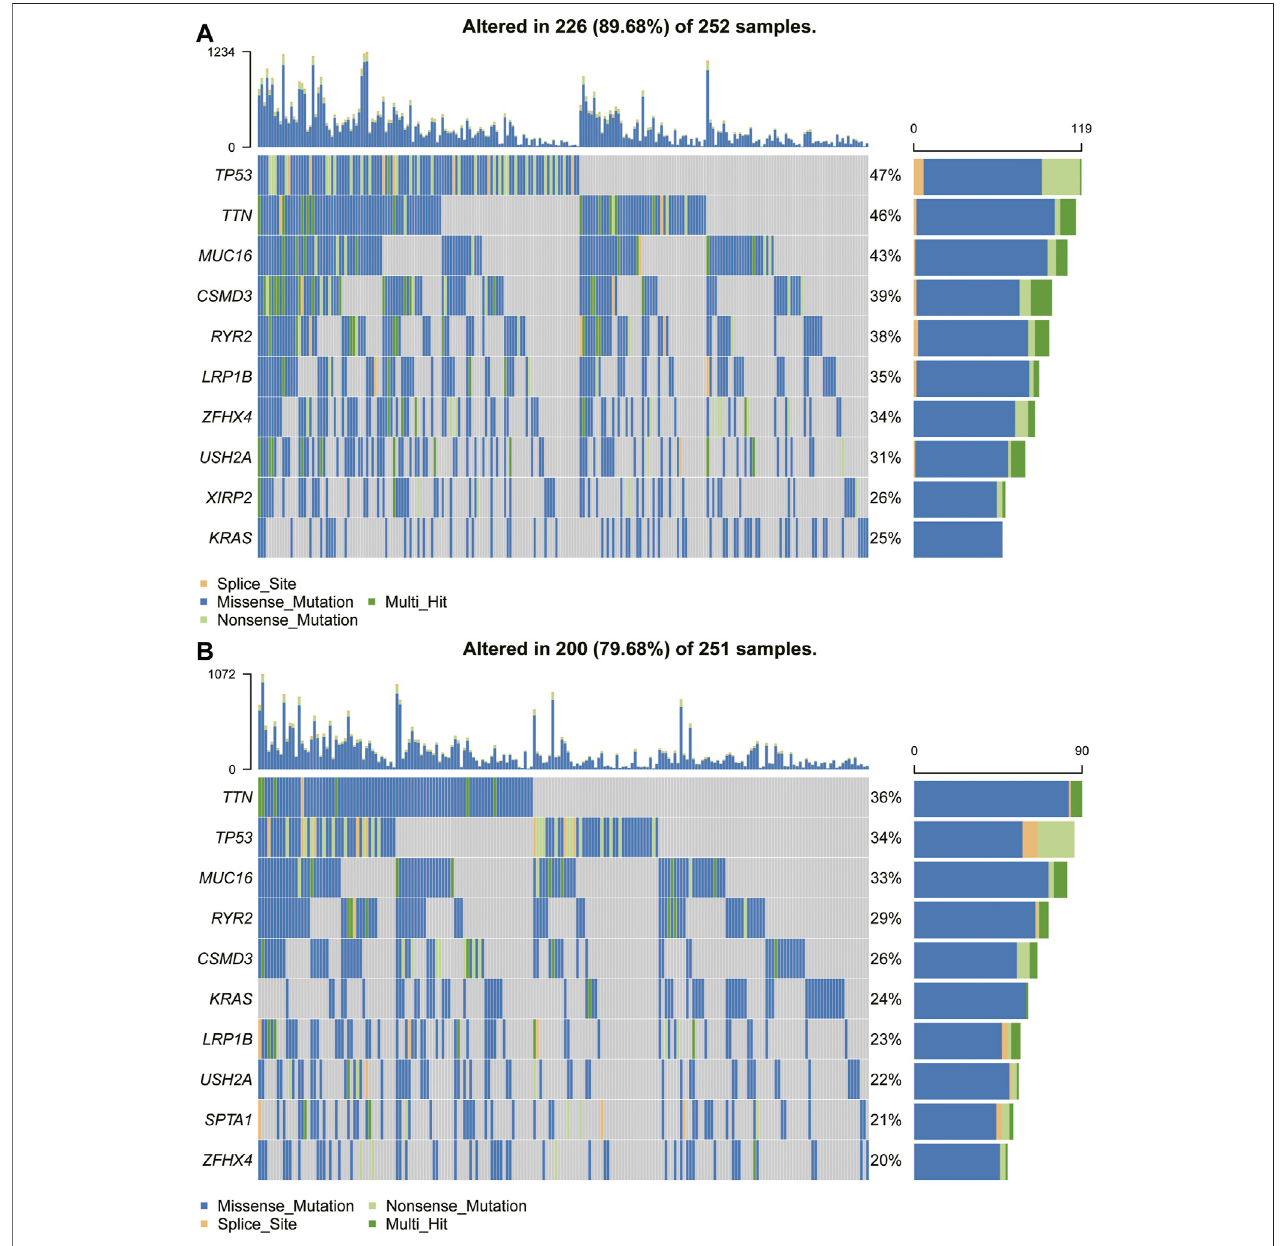
FIGURE 9 | Gene mutant frequency in high- and low-TPD52L2 groups. (A) Gene mutant frequency (top 10) in the high TPD52L2 expression group. (B) Gene mutant frequency (top 10) in the low TPD52L2 expression group.